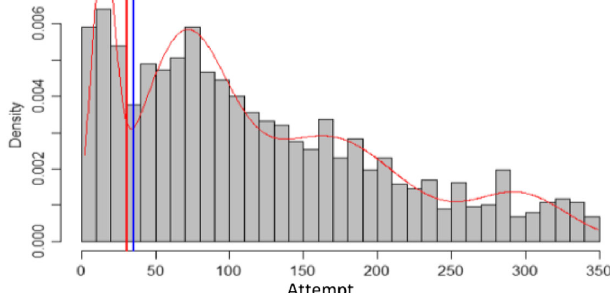
FIG. 6. Example of multicomponent mixture model fit of the duration distribution, with maximum duration of 350 sec. The red line indicates the cutoff generated by the algorithm at 30 sec, and the blue line indicates the average cutoff for all durations at 35 sec.